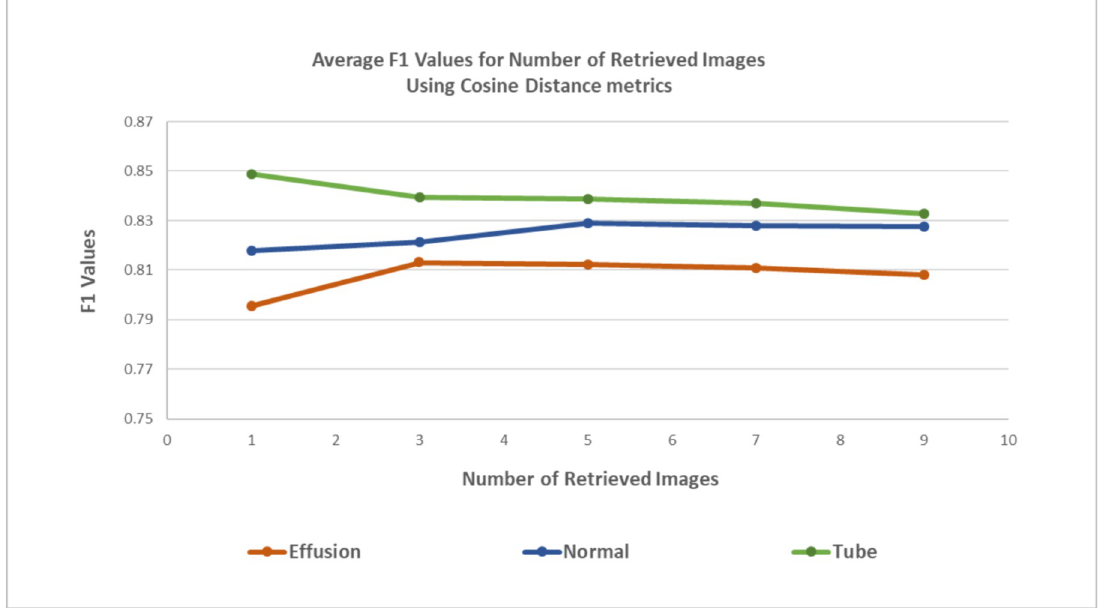
Fig 7. F1 Values for each category for Cosine distance metric.